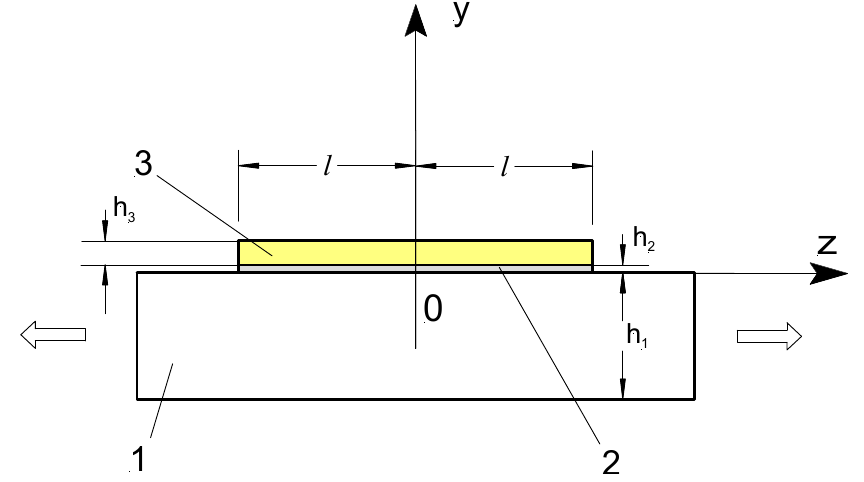
Figure 1. Schematic illustration of a coated specimen illustrated on YZ axis: 1 — substrate; 2 — bond coat (adhesion layer); 3 — top ceramic coating. Designations: h 1 , h 2 , h 3 — thicknesses; l— the distance from the edge to the center of the coat.